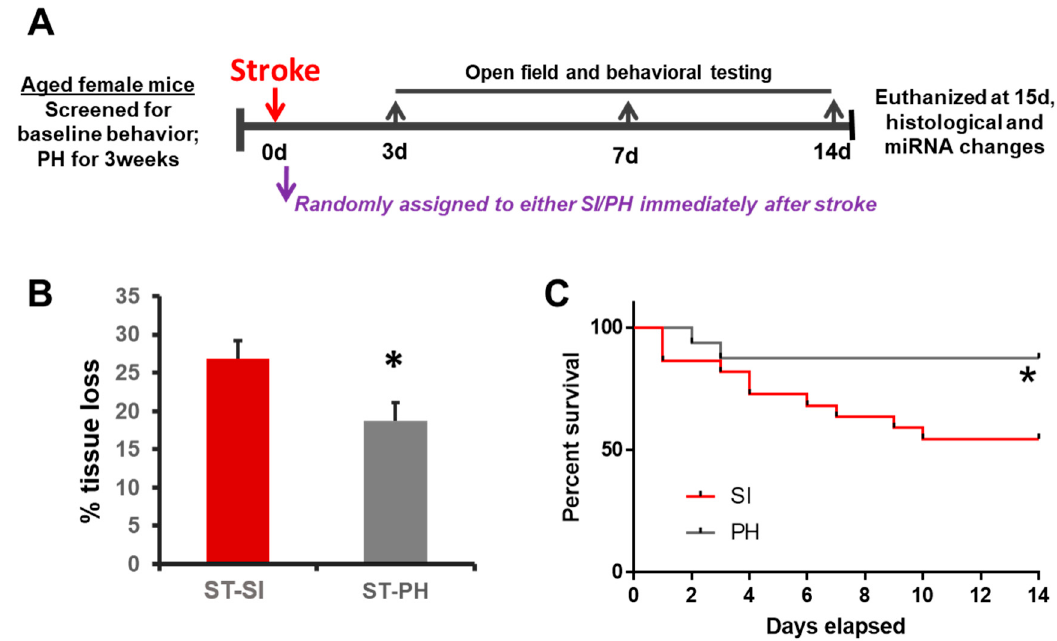
Figure 1. Social isolation immediately after stroke increases infarct size and mortality in aged female mice. ( A ) The exper- imental timeline illustrates the study design. Animals were screened for baseline behavior and immediately assigned to either pair-housing or isolation. The animals were randomly assigned and housed either in continued pair-housing or separated and housed singly (SI). Behavioral testing was performed on days 3, 7 and 14. Mice were euthanized on day 15 for infarct analysis. ( B ) Post-stroke SI (ST-SI) mice had significantly more atrophy compared to post-stroke pair-housed mice (ST-PH) ( n = 9/group; * p = 0.024). Student’s t-test was used after the normality of data was confirmed. ( C ) The socially isolated mice had significantly higher mortality compared to pair-housed mice ( n = 22 in SI; 16 PH initially. * p = 0.043). P value was obtained from the log-rank test.